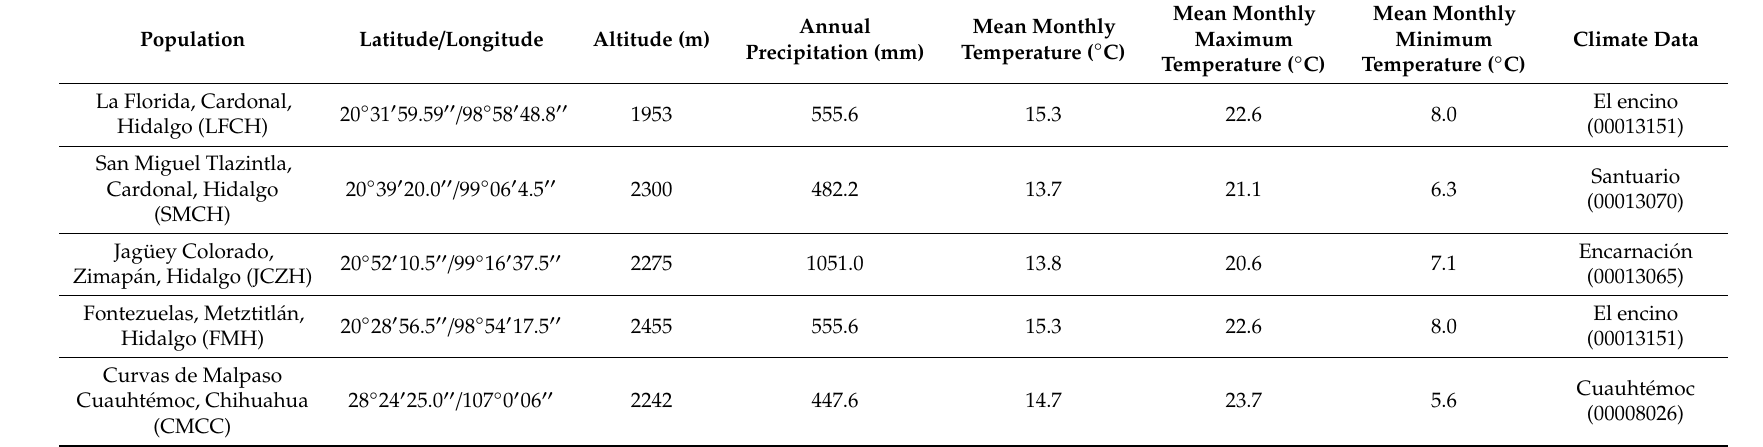
Table 4. Geographical and climatic data of the five populations of P. cembroides included in this